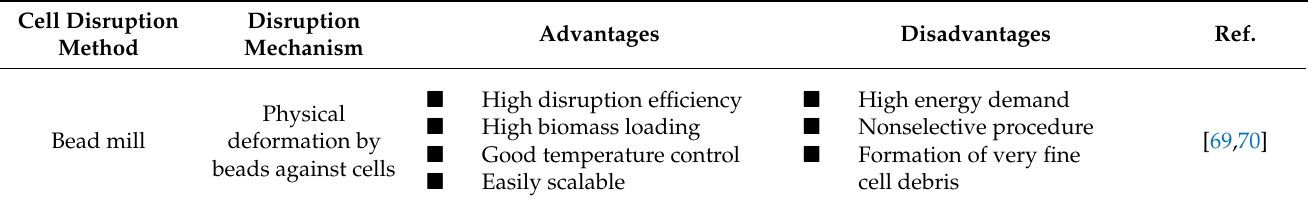
Table 2. Main advantages and disadvantages of several methods of cell